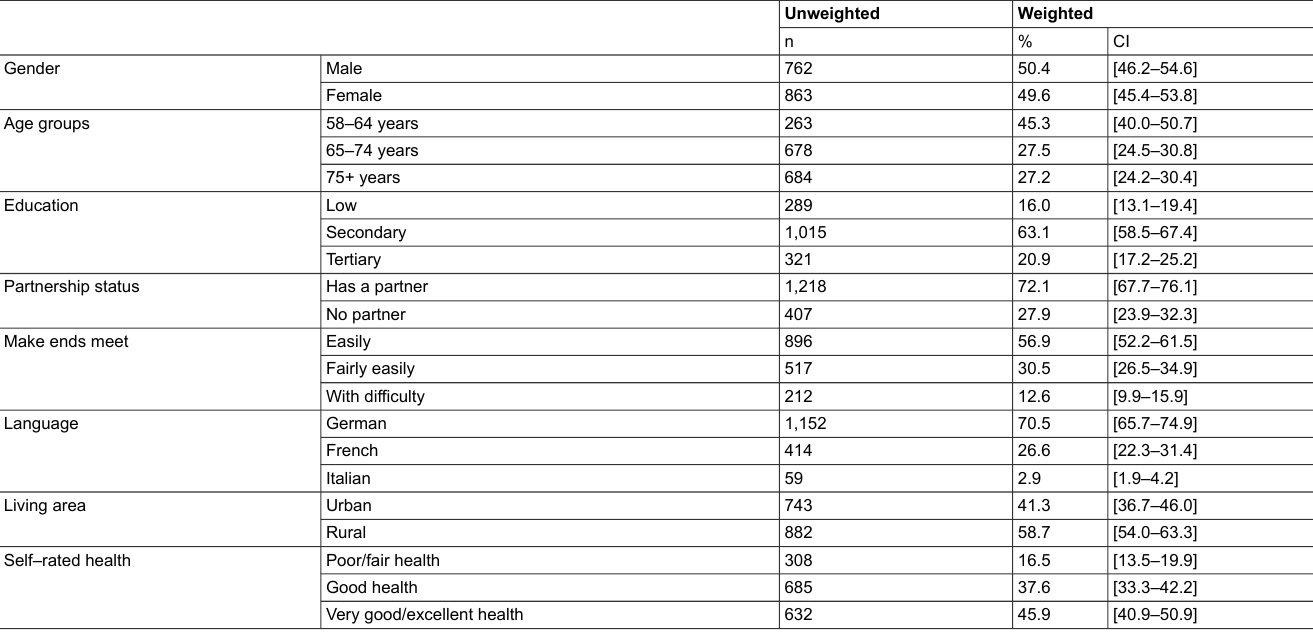
Table 1: Characteristics of the study population, adults aged 58+, SHARE Switzerland, 2019/2020, n =